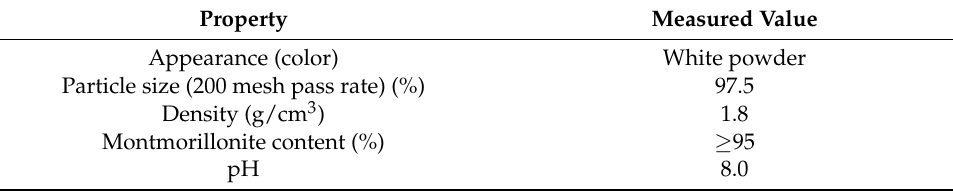
Table 3. Physical and chemical properties of